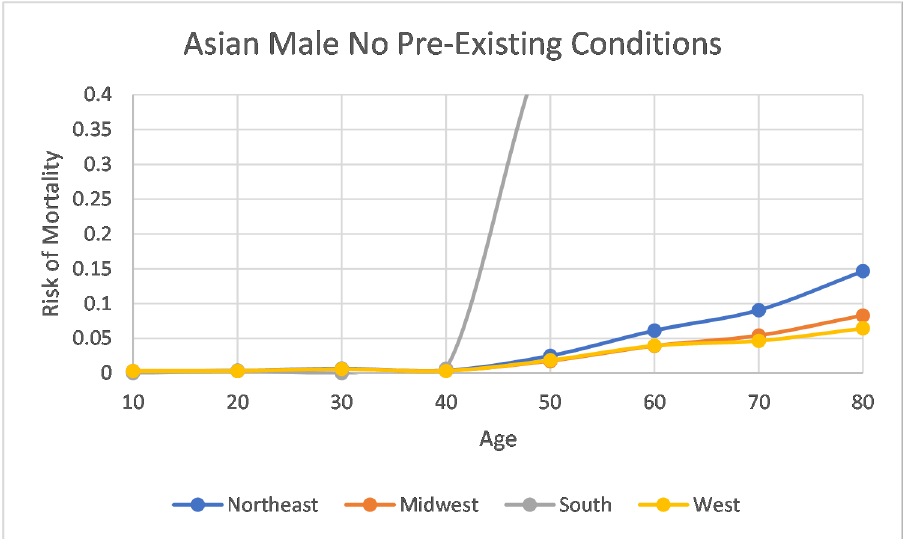
Figure 10. Probability of mortality for an Asian male with no pre-existing conditions for certain age groups. Given as a decimal. Same information as in Table